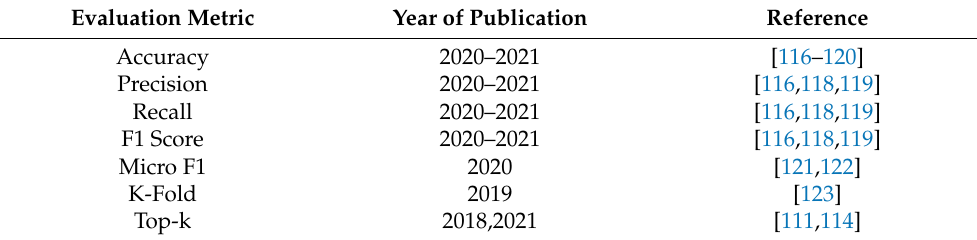
Table 5. Commonly used evaluation metrics for video